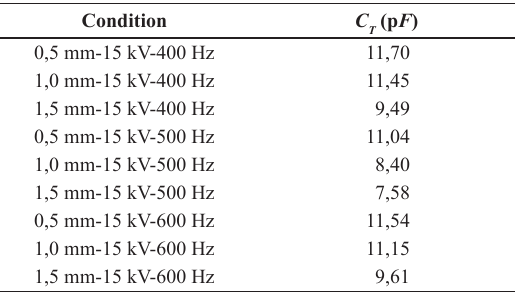
Table 3. DBD reactor total Capacitance for distance variations at 400,500 and 600 Hz frequencies